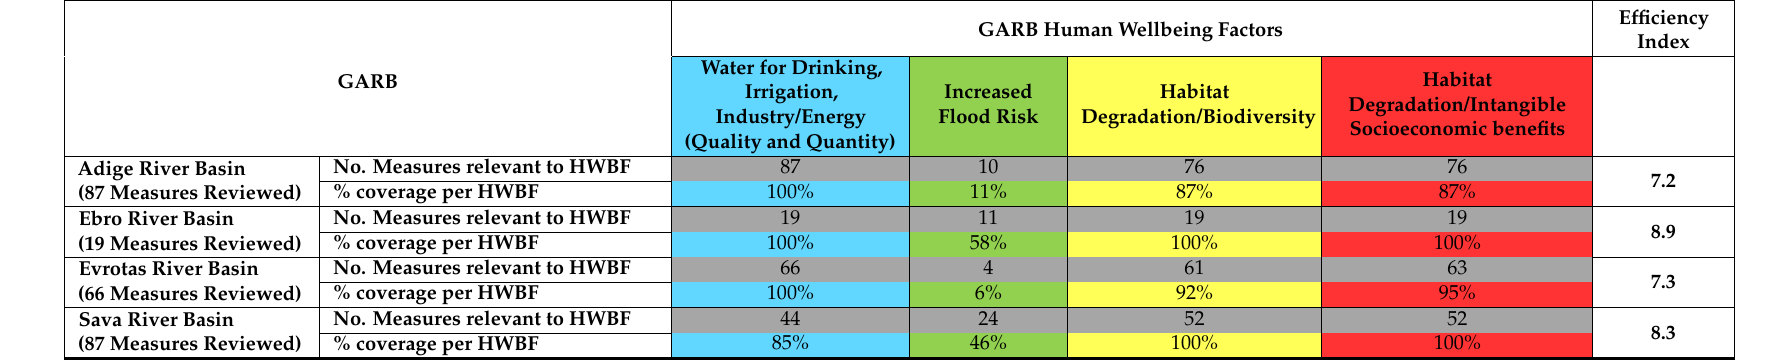
Table 3. The analysis of Programs of Measurements (PoMs) at the GLOBAQUA River Basins (GARB) level by considering the Human Wellbeing (HWB) factors* (Developed from the following: GLOBAQUA Deliverables 2.5, 8.1, 8.2, 8.3, 9.2, 10.3;